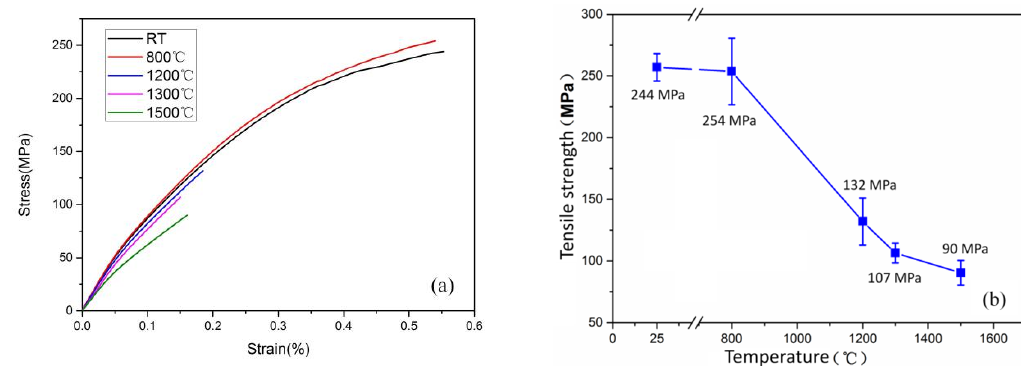
Figure 2. ( a ) Tensile stress–strain curves and ( b ) variations of tensile strength of SiC–SiC at different temperatures in air.